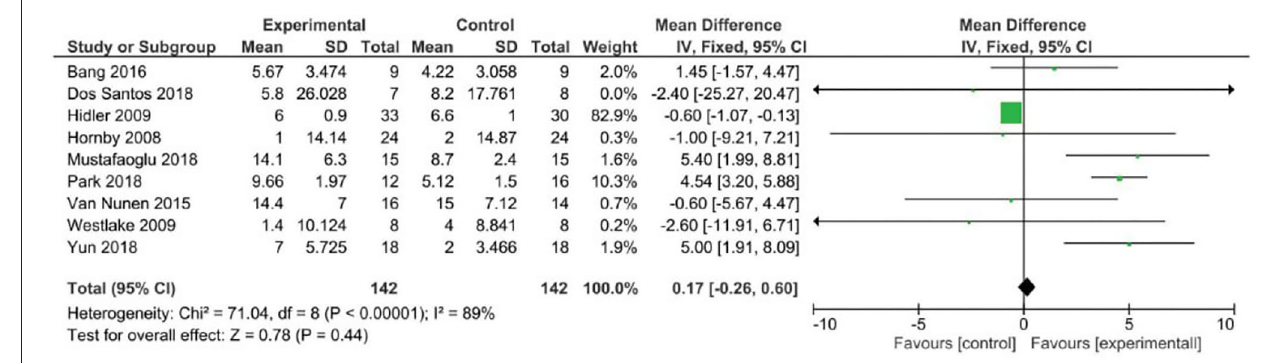
FIGURE 2 | Forest plot for Berg Balance Scale (BBS).